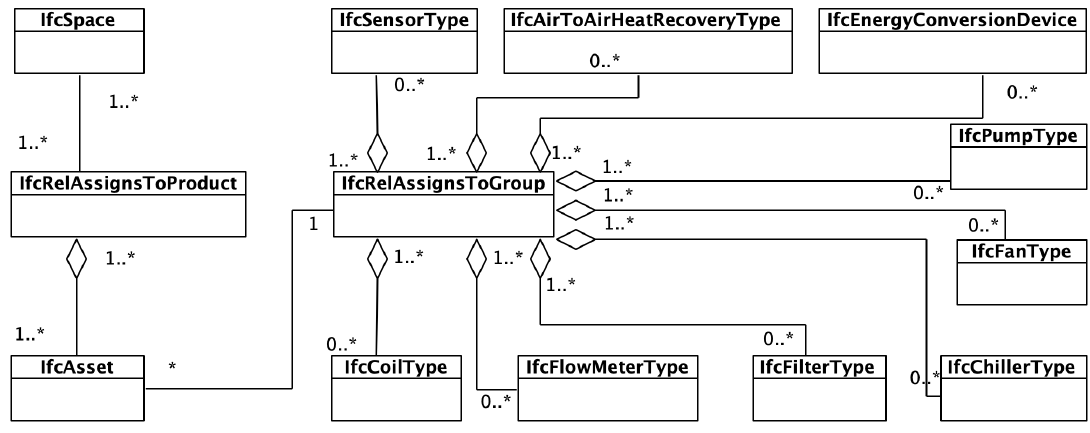
Figure 3. UML schema of the proposed approach implemented in the case